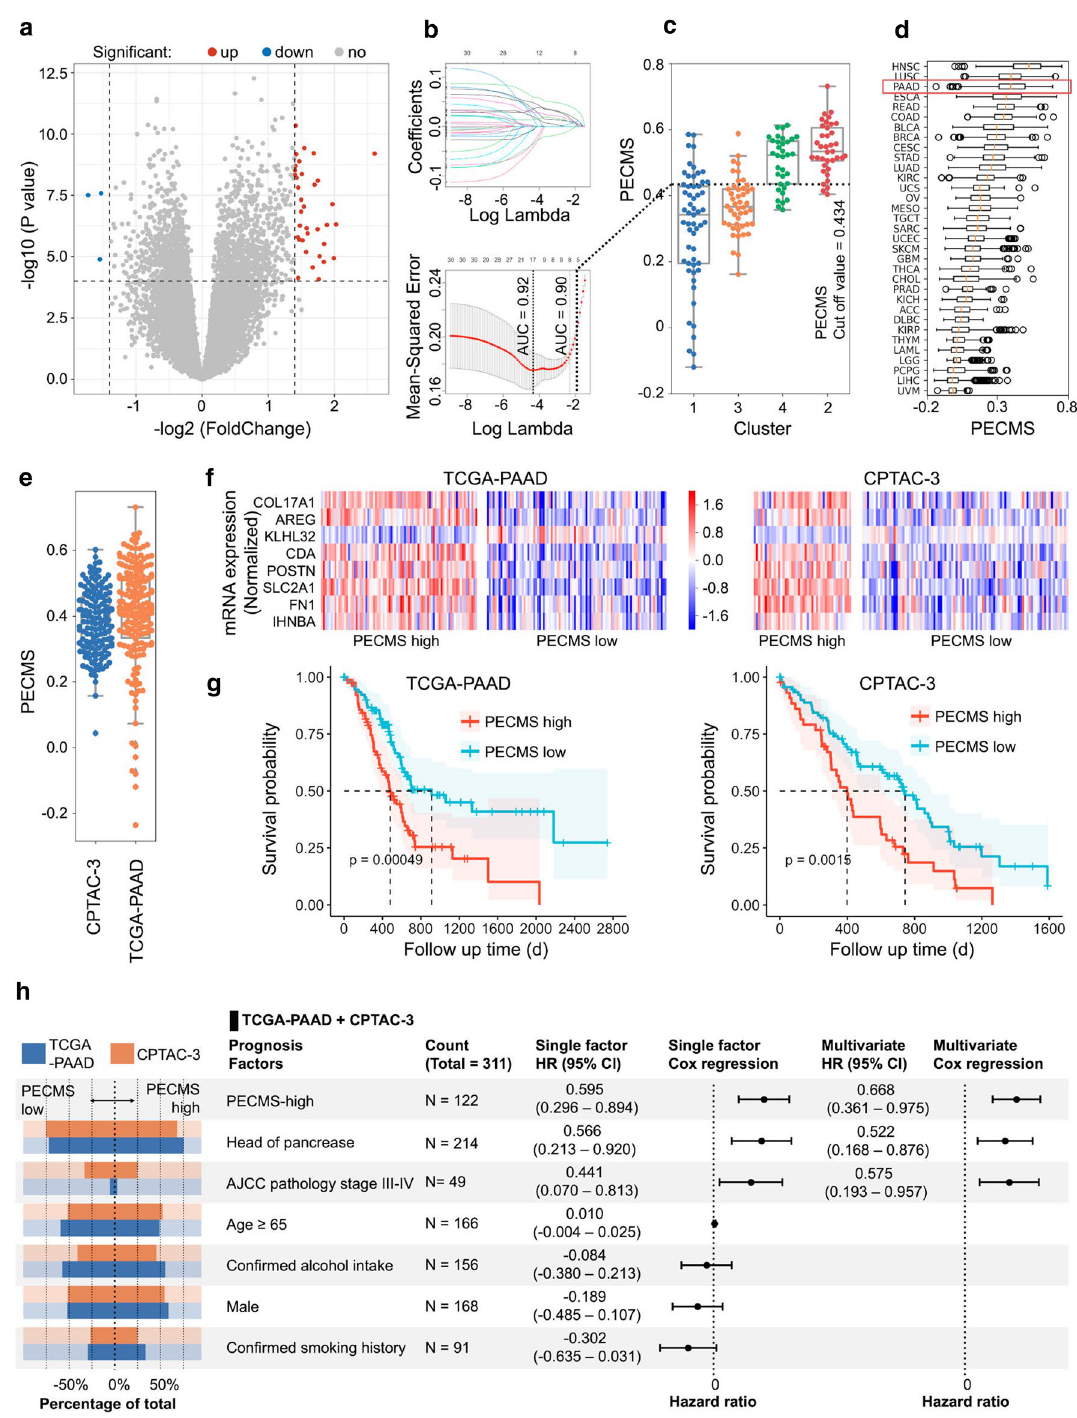
Fig. 2 Establishment of the PECMS model and the effect of PECMS on survival ( a Limma analysis to identify differentially expressed genes between the PECMS-high and PECMS-low groups. b Lasso process, AUCs of the model when the log lambda value at the minimum MSE and 1SE MSE were 0.90 and 0.92, respectively. c PECMS in different clusters of patients. d PECMS in different cancers in TCGA database. e PECMS in patients of the TCGA-PAAD and CPTAC-3 cohorts. f mRNA expression of PECMS feature genes in TCGA-PAAD and CPTAC-3. g Survival curves of TCGA-PAAD and CPTAC-3. Patients were grouped by the level of PECMS. h Clinical features, including PECMS in TCGA-PAAD and CPTAC-3, as well as their HR for survival in single-factor and Multivariate Cox